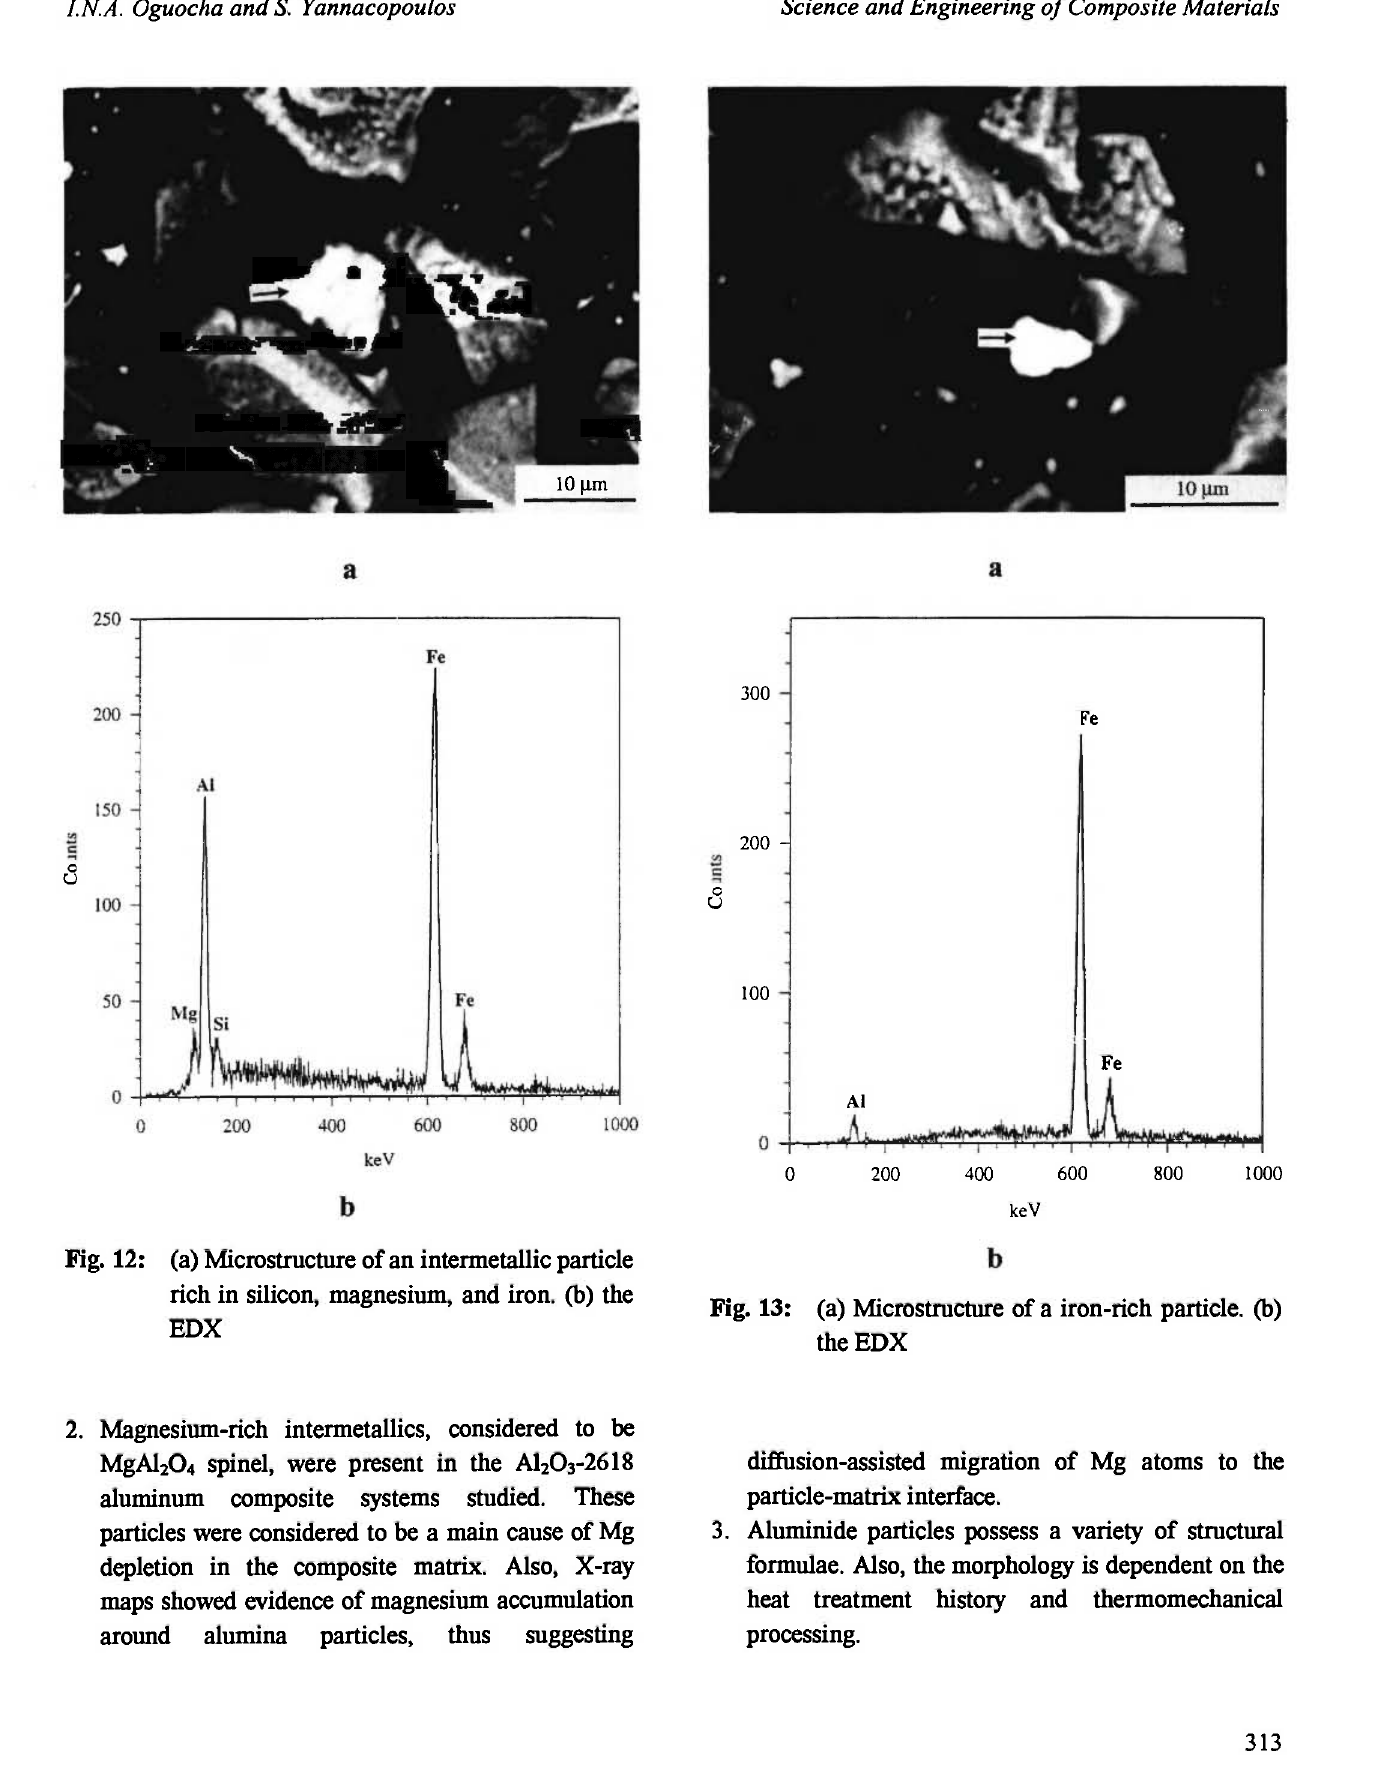
Fig. 13: (a) Microstructure of a iron-rich particle, (b) the